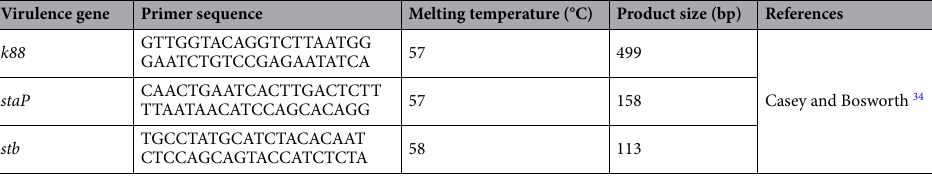
Faecal DNA isolation and real‑time qPCR. Ten (5 female and 5 male) pigs in each experimental group were randomly selected for faecal collection. DNA was extracted from faeces samples from each experimental group using the Quick-DNA Fecal/Soil Microbe Miniprep Kits (Zymo Research). The qPCR was conducted separately for each virulence gene, with detection using the StepOnePlus Real-Time PCR System with StepOne Software V2.3 (Applied Biosystems) and SYBR Green-Based fluorescent dye. Each faecal DNA sample was tested in trip- licate, and the results were averaged and displayed as copy number/μL. The assays utilized 50–200 ng of stool DNA, 8 μL of water, 0.5 μL each of 10 μM forward and reverse primers (Table 3), and 10 μL of PowerUp SYBR Green Master Mix (Applied Biosystems). The real-time qPCR was carried out with the following conditions: initial denaturation at 50 °C for 2 min, 95 °C for 2 min, 40 cycles of denaturation at 95 °C for 15 s, annealing at 55 °C for 15 s, and extension at 72 °C for 1 min. Gene copies were determined by absolute quantification using the standard curve fitted for each 96-well plate. R 2 values for a linear model fit with cycle threshold (Ct) vs. log dilution of DNA in the standard curve ranged from 1.00 to 0.988.